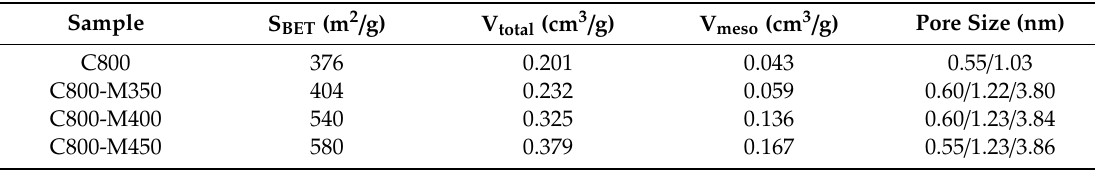
Figure 4. N 2 adsorption-desorption isotherms ( a ) and density functional theory (DFT) pore size distributions ( b ) of the prepared carbon materials. Table 1. Pore structure parameter of carbon materials.